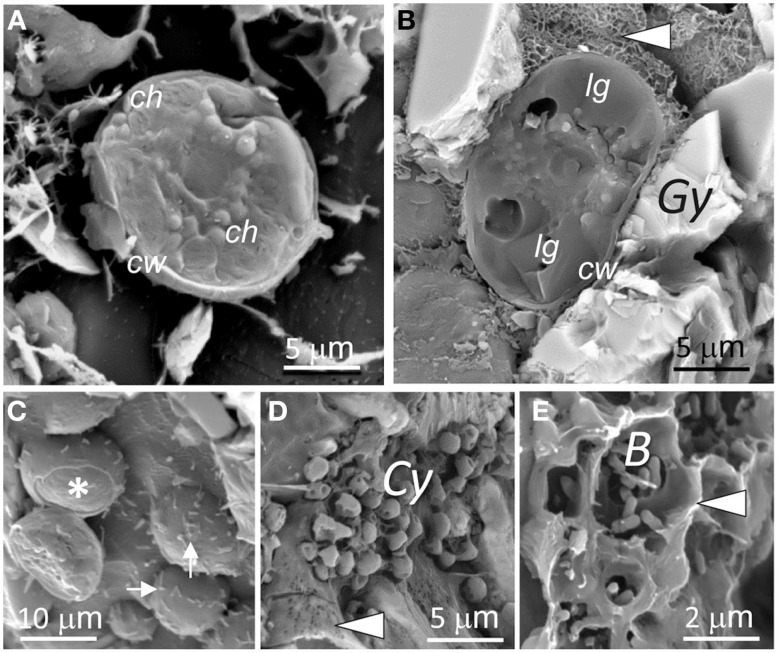
LT-SEM images of endolithic microorganisms and extracellular polysaccharides. (A–C) Fractured algae cells with ultrastructural elements such as: cell walls (cw), chloroplasts (ch), lipoidal filling (lg), and gypsum particles (Gy); detached cell wall, asterisk; rod shaped microorganisms (potentially heterotrophic bacteria) attached to algae, white arrows; arrow head in (B) point to EPSs. (D) Image showing cyanobacteria (Cy) aggregates and slime EPSs (arrow head). (E) Image showing bacteria (B) evolved by capsular EPSs (arrow head).